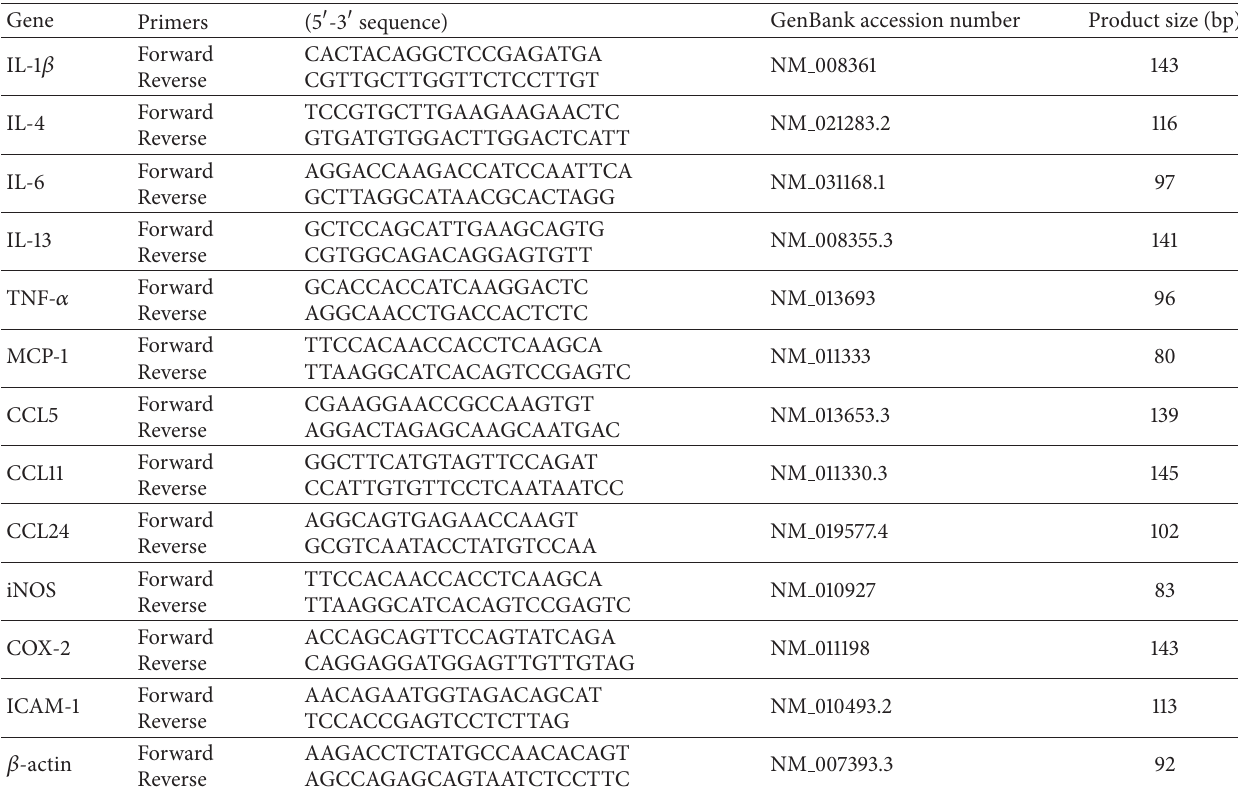
Table 1: Primers used in real-time PCR analyses of mRNA